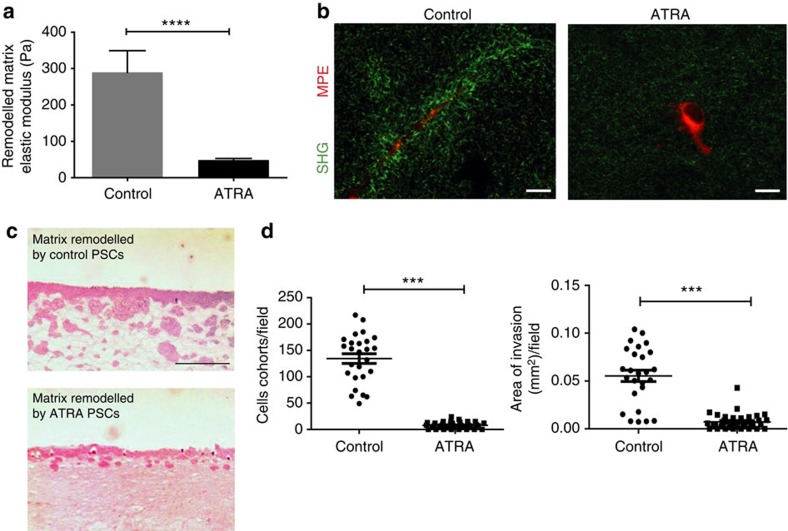
ATRA impairs PSCs capacity to remodel the ECM to promote cancer invasion.(a) Elastic modulus for collagen Matrigel matrices previously remodelled by PSCs expressed as mean±s.e.m.; control n=113 and ATRA n=114 measurements obtained in three independent experiments. (b) Collagen second-harmonic signals (green) and cells (red). Scale bar, 20 μm. (c) Representative images of haematoxylin and eosin immunofluorescence staining showing AsPC1 cancer cell invasions. Scale bar, 50 μm. (d) AsPC1 invasion expressed as number of invading particles and area, respectively. Each point represents a different section. In all panels, ***P<0.001; ****P<0.0001; (t-test).